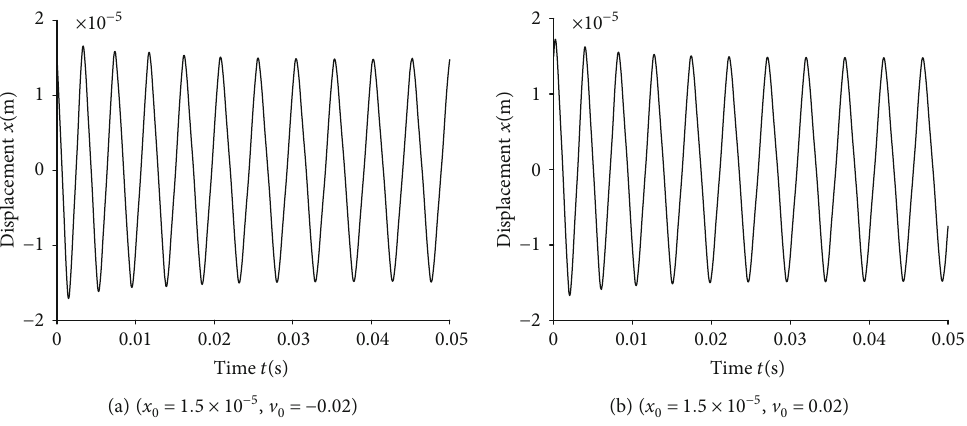
= 1 : 8A , q = 1 : 2 × 10 − 4 m 3 /s . 0 0